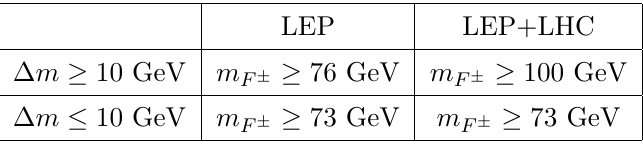
Table 2 . Combined absolute limits on charginos in the region m Z = 2 (cid:20) m for the simpli(cid:12)ed model of section 3. LEP limits are obtained from the searches in table 1,